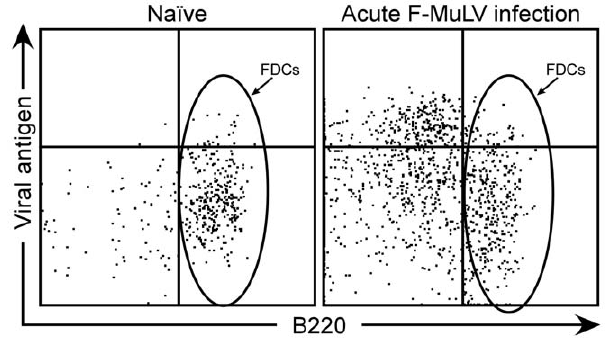
Figure 6. Analysis of follicular dendritic cells (FDCs) for Friend virus infection. Flow cytometry was used to detect cell surface FV glycosylated gag using the monoclonal antibody mAb34 (Viral antigen). FDCs are B220 + cells gated for lack of expression of CD11c, CD8, CD19, CD4, CD3, CD11b and Gr-1, but staining positive for MHCII. The representative plot of FDCs from an acutely infected mouse shows no viral antigen staining above background (Naı¨ve) levels.